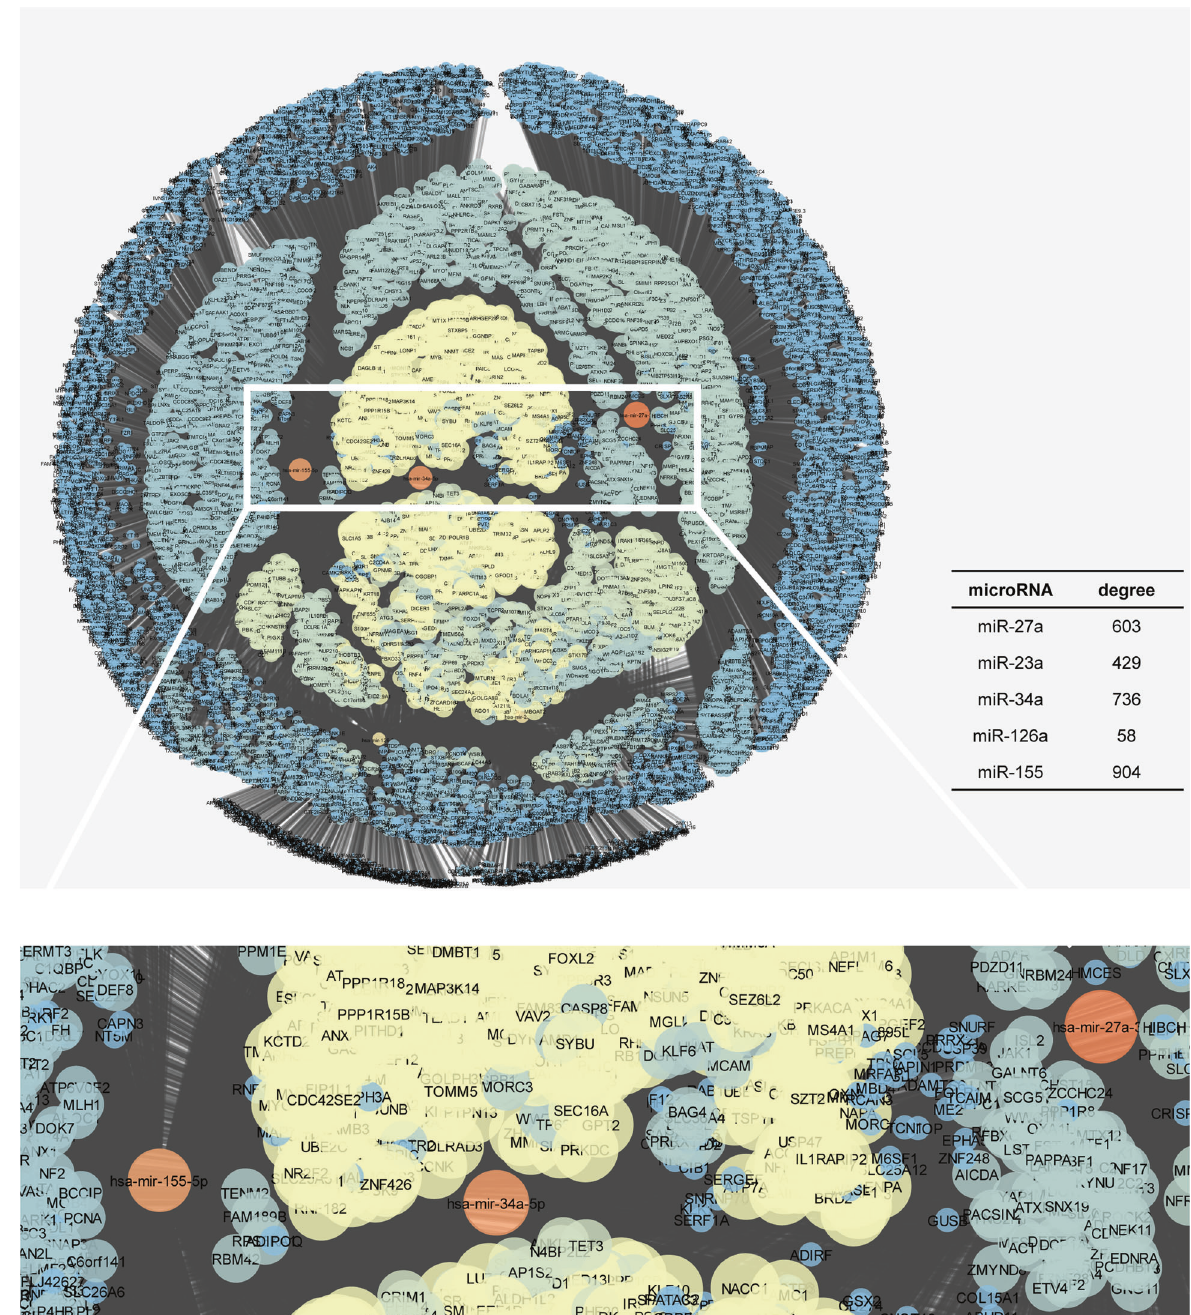
Fig. 2 The miRNA-gene network predicted by miRNet analysis. The predicted network (Prefuse force directed layout based on edge betweenness) included about 20000 edges (connections) and 10000 nodes (miRNAs or genes). Only three nodes showed the highest degree (included table) and particularly the highest betweenness centrality (red color). From left to right, the red nodes represent miR-155, miR-34a, and miR-27a, bearing also the highest degree values. These mentioned node parameters strictly in fl uence the stability of the network. Centrality metric analyses were carried out with Cytoscape and network parameters were plotted in the graphic representation: closeness centrality (proportional to node dimension), betweenness centrality (temperature color scale, blue < red), edge betweenness (proportional to edge